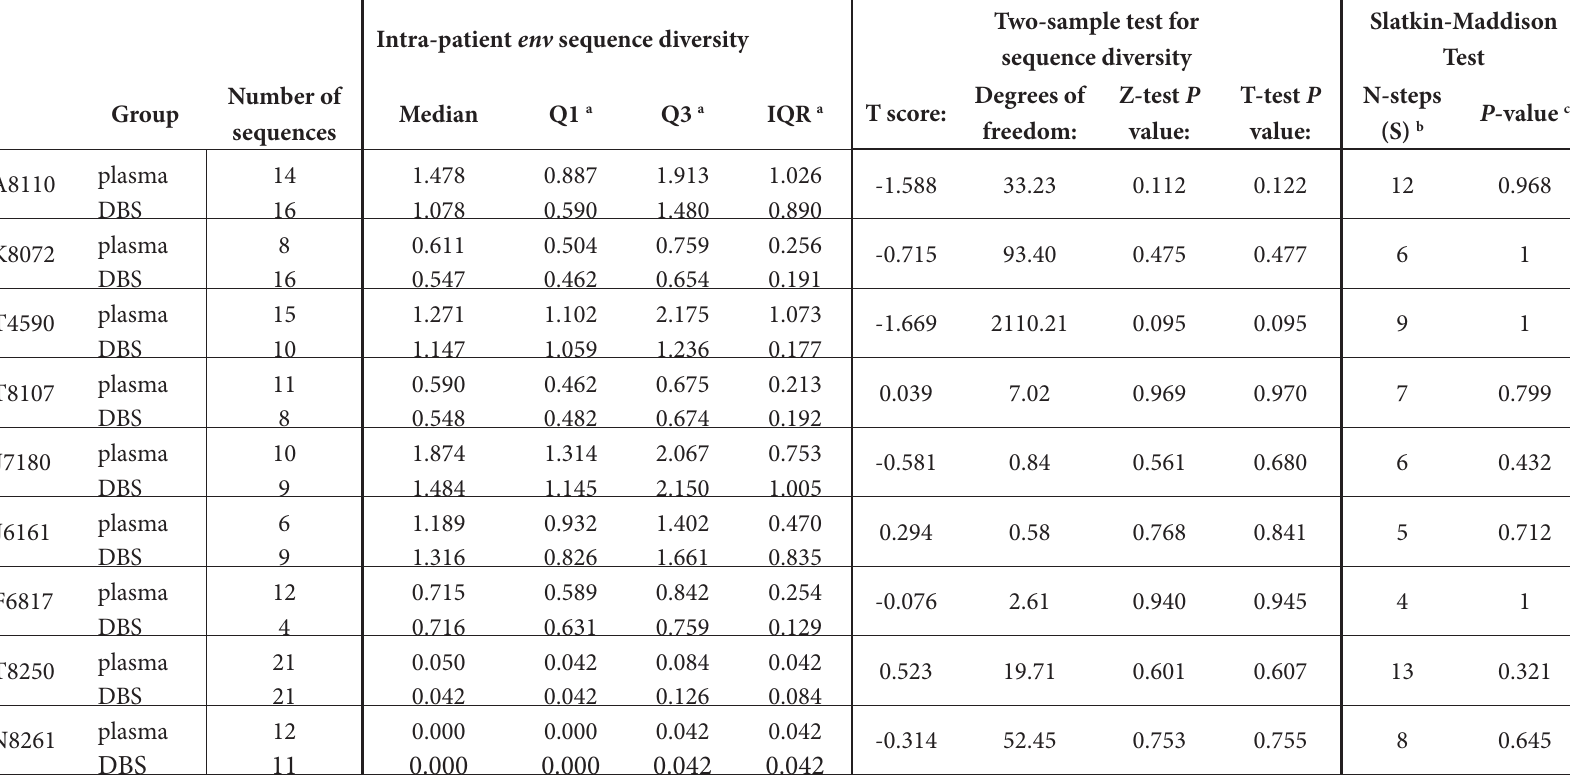
Supplementary Table 1. HIV-1 env diversity and compartmentalization tests between two viral populations (plasma vs DBS) a) Rank-ordered di- versity data were divided into four equal parts using quartiles: first (Q1), third (Q3) quartiles and interquartile range (IQR = Q3-Q1) are shown as a measure of variability. b) S denotes the number of changes (in parsimony steps) of a character corresponding to population membership.c) Proba- bilty of S or fewer steps in 1,000 randomized tree